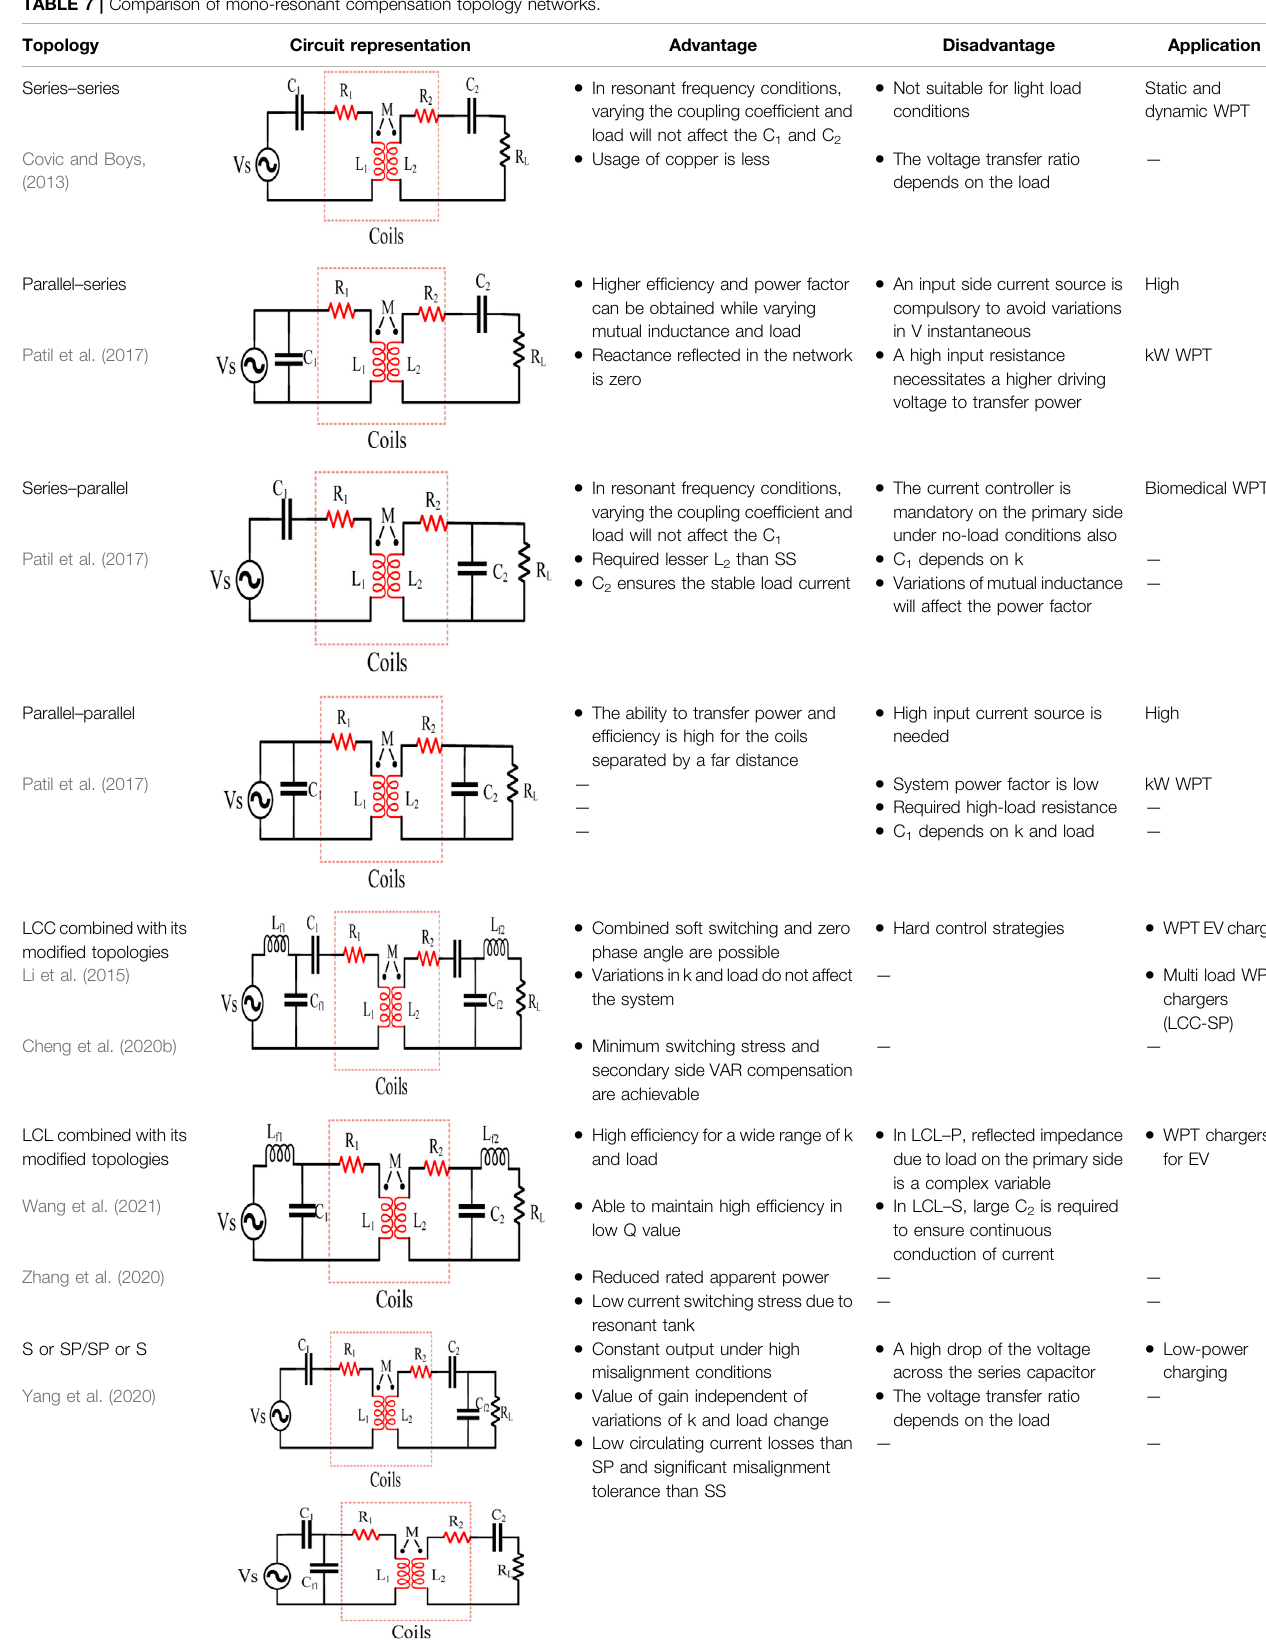
TABLE 7 | Comparison of mono-resonant compensation topology